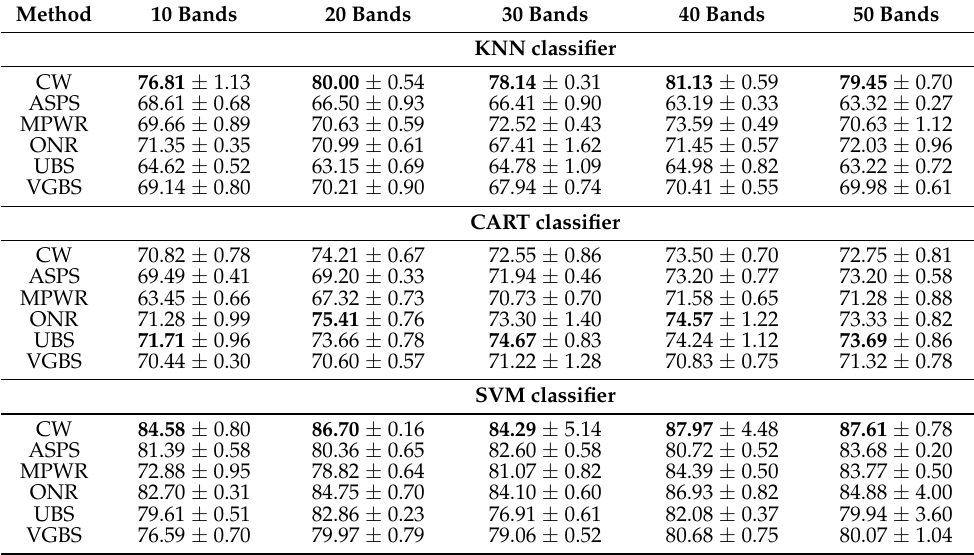
Table 3. Indian Pines image results (overall accuracy and standard deviation in %)